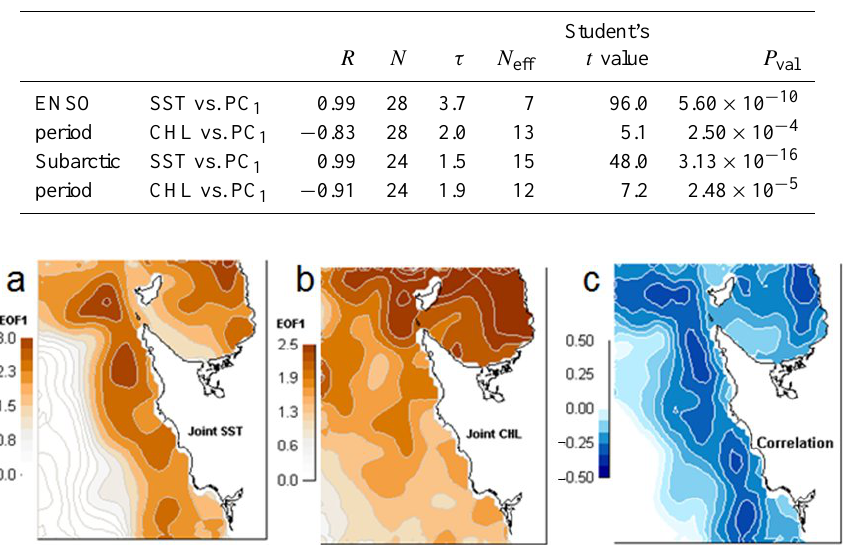
Fig. 4. Spatial patterns for mode 1 of the joint EOF analyses of (a) SST, (b) chlorophyll a (accounting for 80% of the total variance) and (c) the correlation map between monthly anomalies of SST and chlorophyll a . The largest negative correlations (< − 0.2, the blue areas) are seen along the coast and coincide with the high joint EOF 1 scores (>2.0) of SST (a) . Absolute correlations above R crit ( P <0.05)=0.211, (i.e., the strongest negative correlation) are significant at the 95% confidence